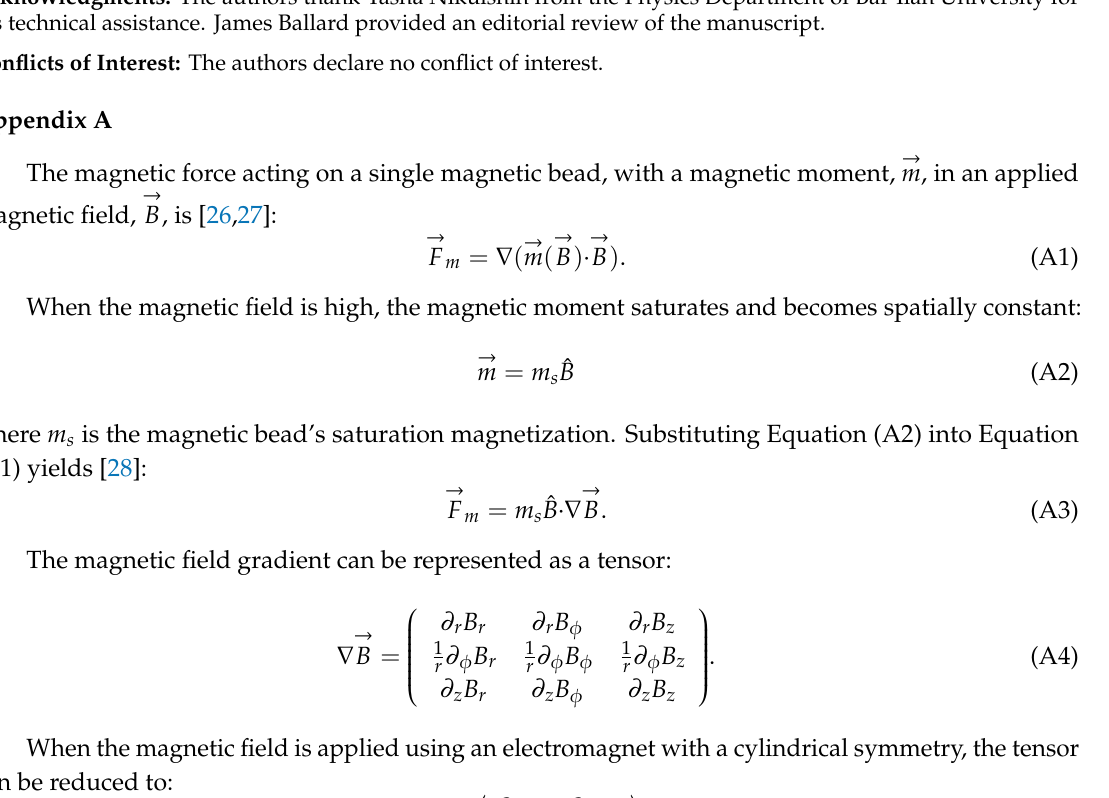
Figure S1: The area between two electromagnets in which the magnetic moment of the M-280 beads saturates. Movie S1: The correlation between the working distance and the distance between the pole